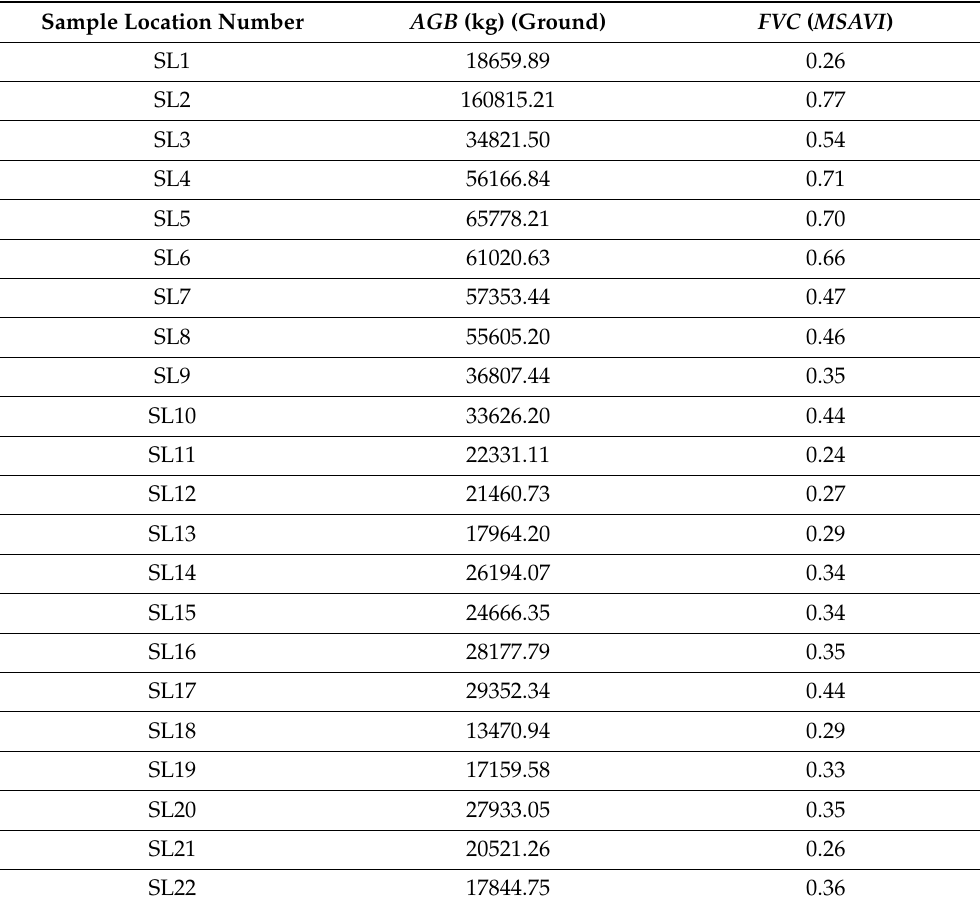
Table 5. Ground forest AGB and selected image forest FVC